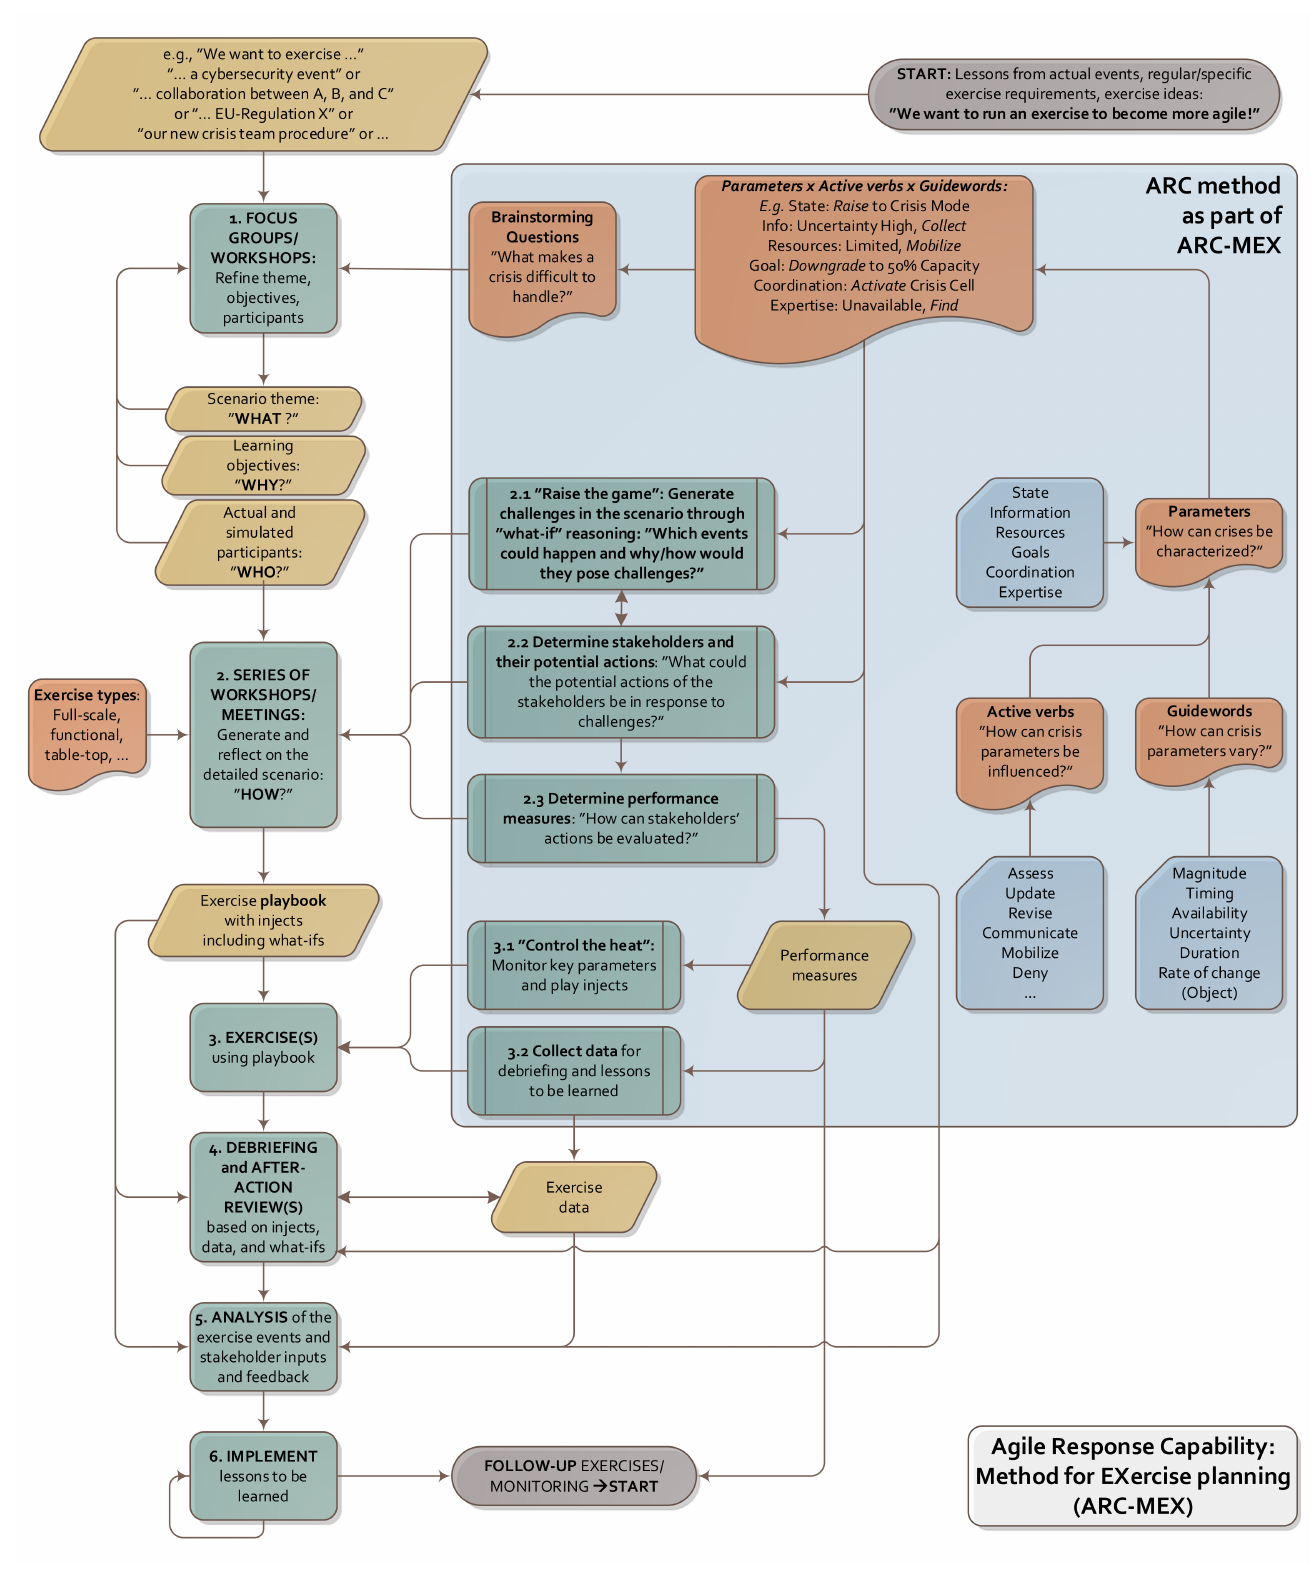
Figure A1. Detailed overview of the ARC-MEX